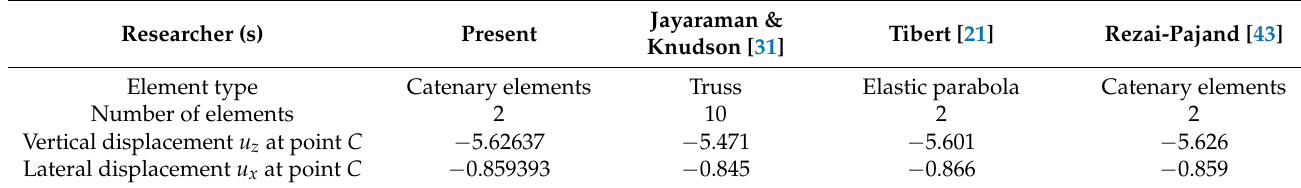
Figure 4. Single cable structures subjected to concentrated loads. Table 1. Comparison of displacement at point C (unit: m).